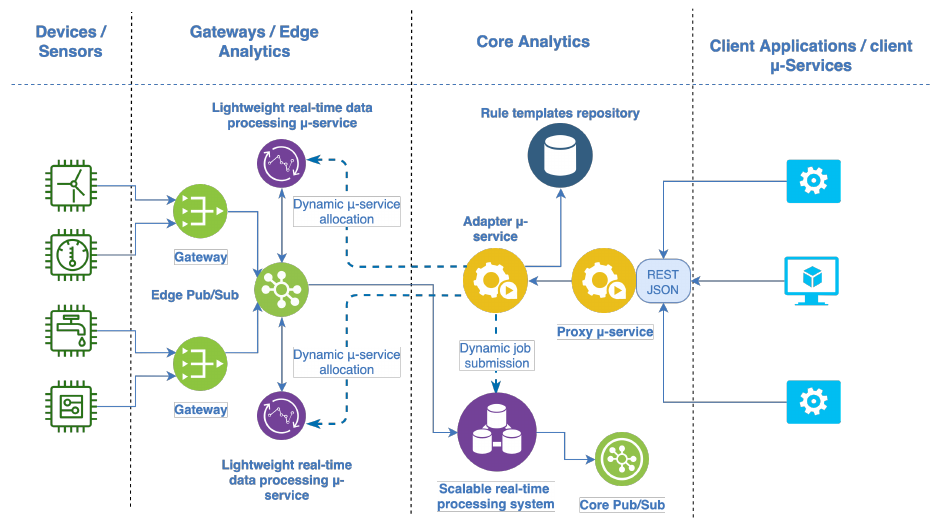
Figure 1. Reference